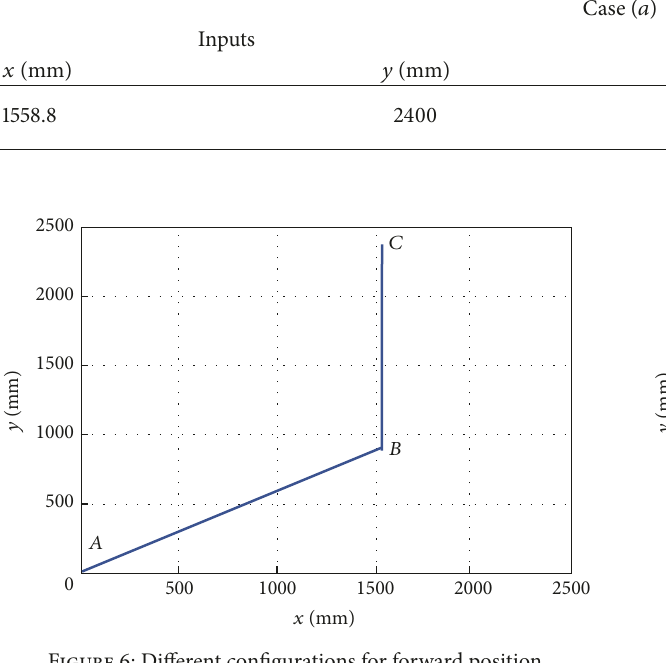
Figure 8: The reachable workspace of the mechanism.